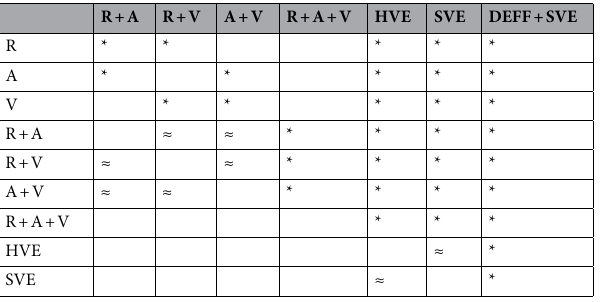
Table 4. Statistical analysis of ensemble models and single models from 20 runs. Here, * denoting the model’s performance is noticeably better than that of other models and ≈ indicating the performance of two models is